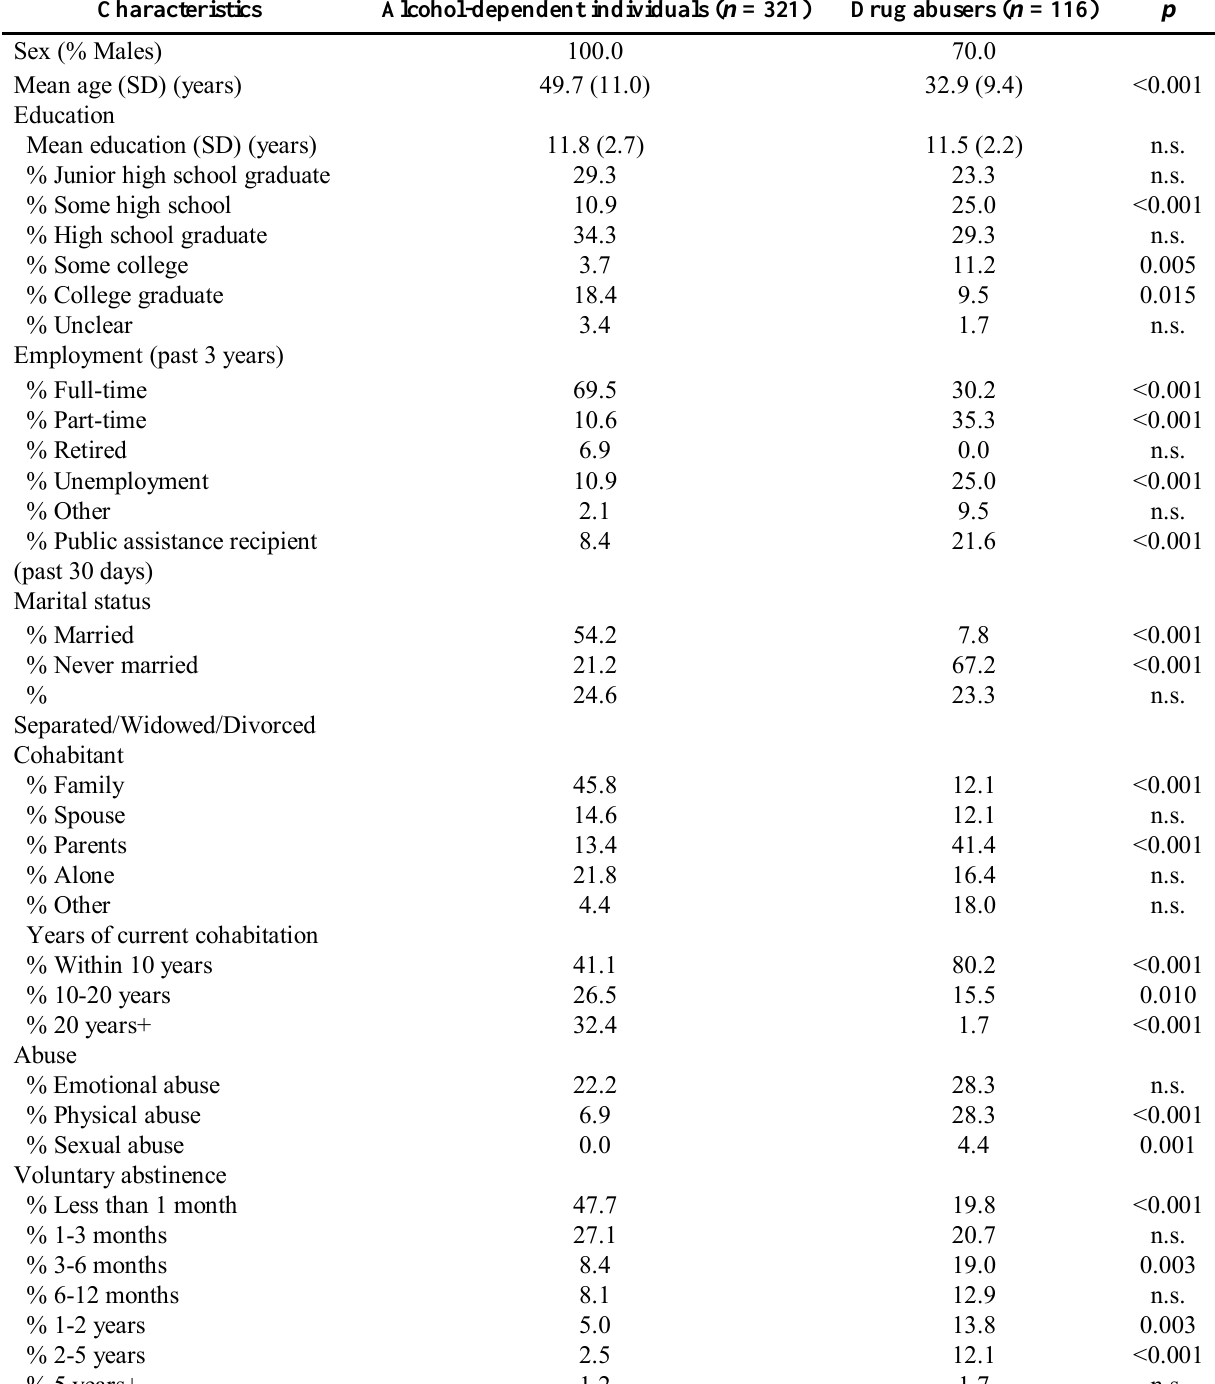
Table 3. Comparison of profiles between alcohol-dependent individuals and drug abusers. Characteristics Alcohol-dependent individuals ( n = 321) Drug abusers ( n = 116) p 100.0